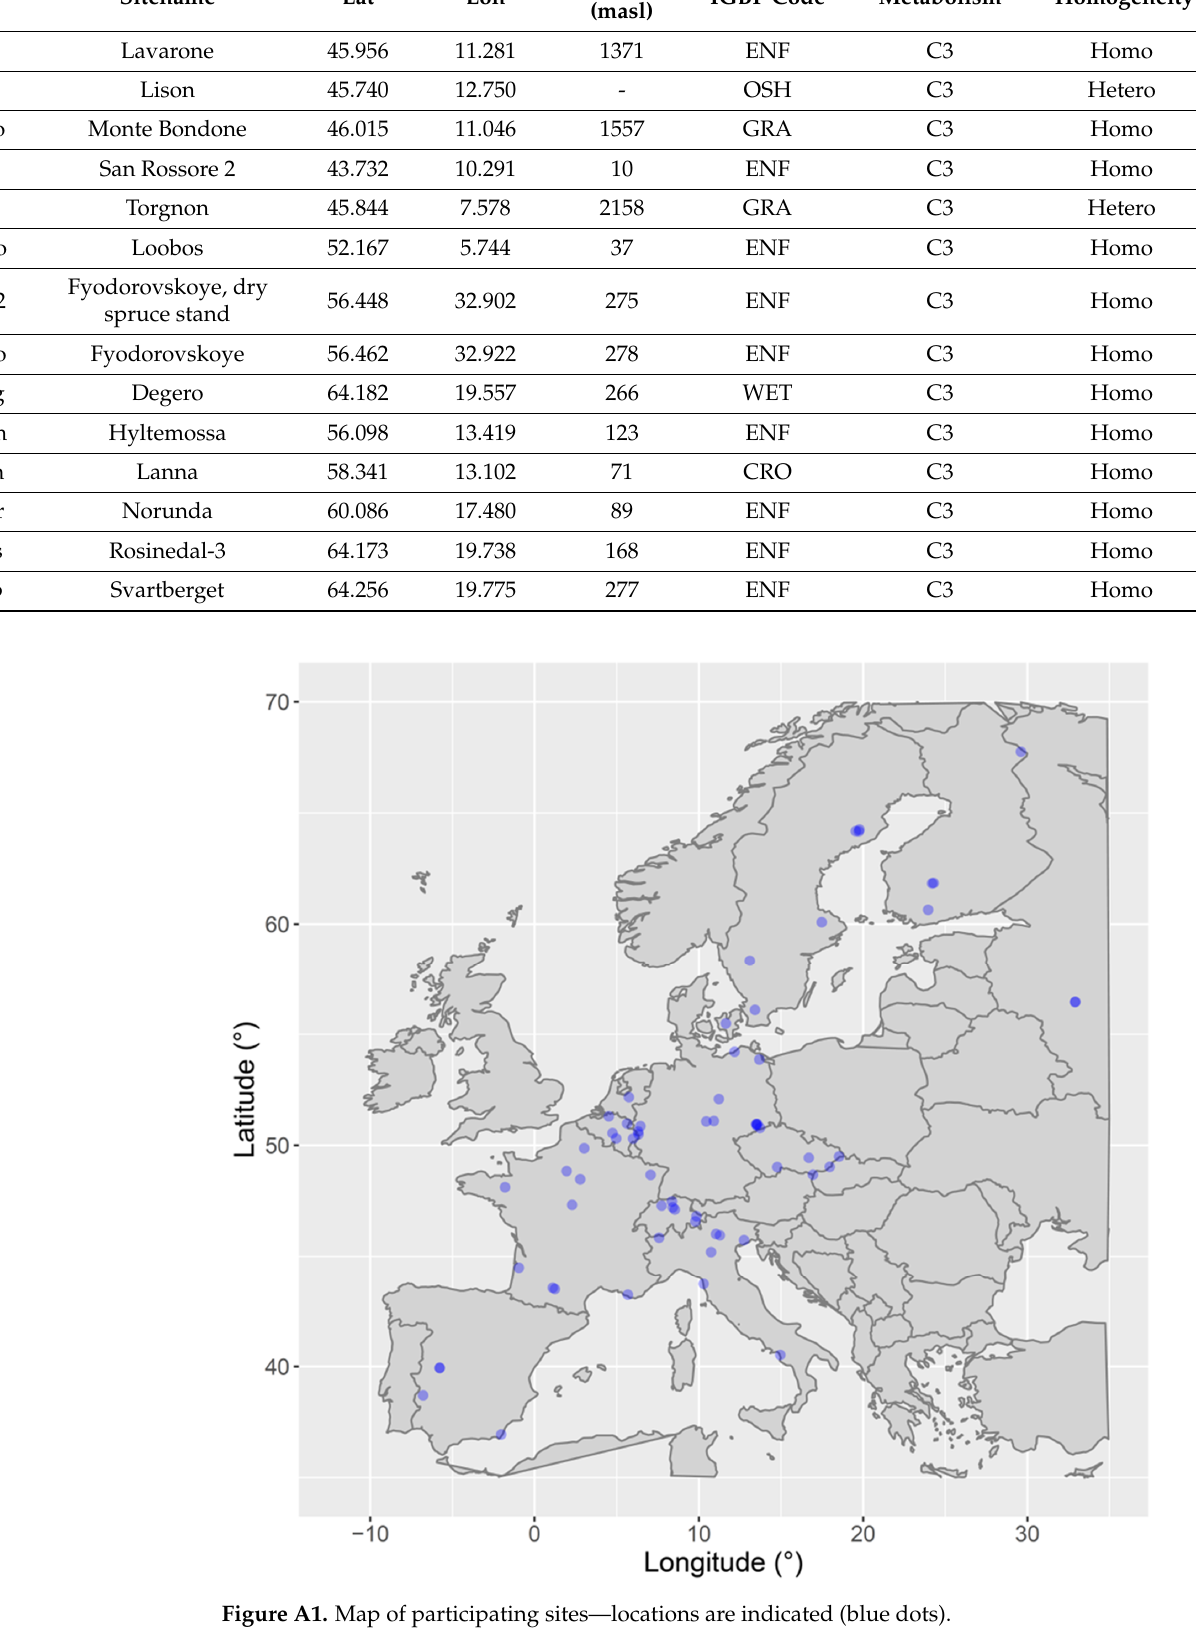
Figure A1. Map of participating sites—locations are indicated (blue dots).